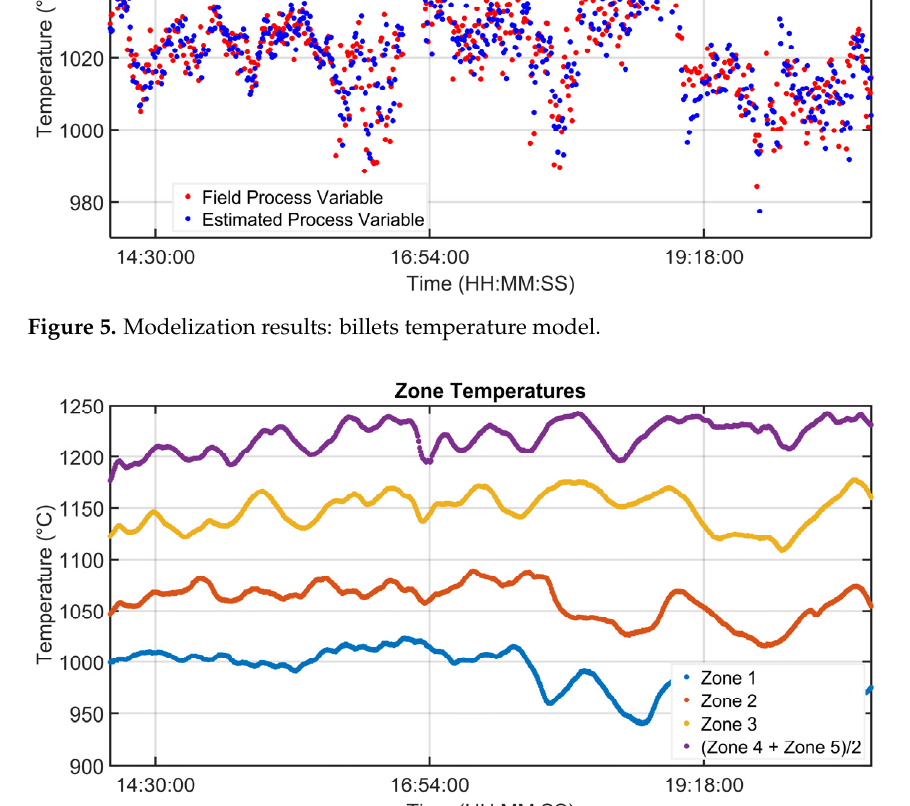
Sensors 2023 , 23 , x FOR PEER REVIEW Figure 6. Modelization results: zone temperatures associated with the billets temperature model.